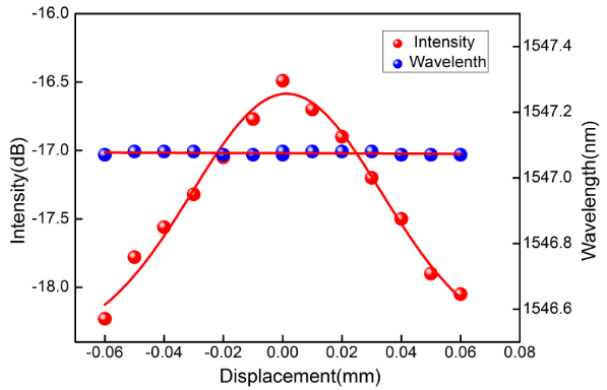
Figure 5. Cladding resonance mode power and wavelength versus displacements.